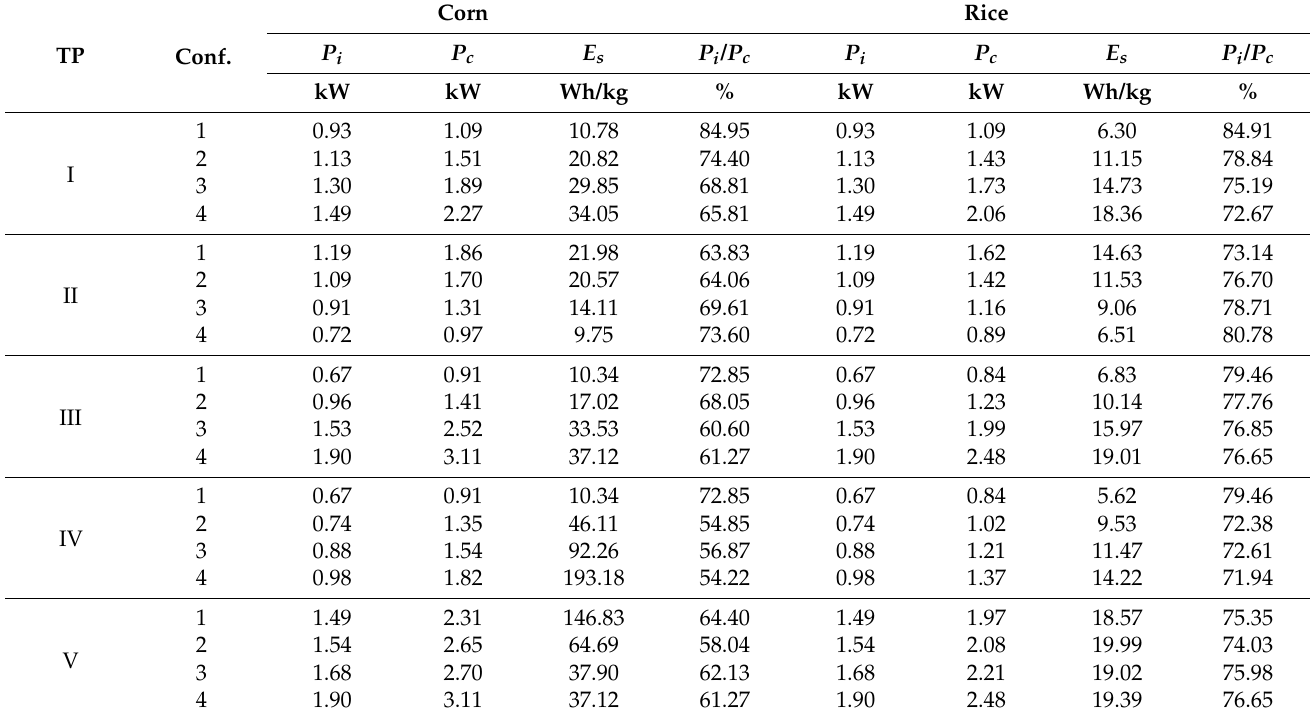
Table 3. Results of power consumption and specific comminution energy tests in the grinding of rice and corn grains for five test